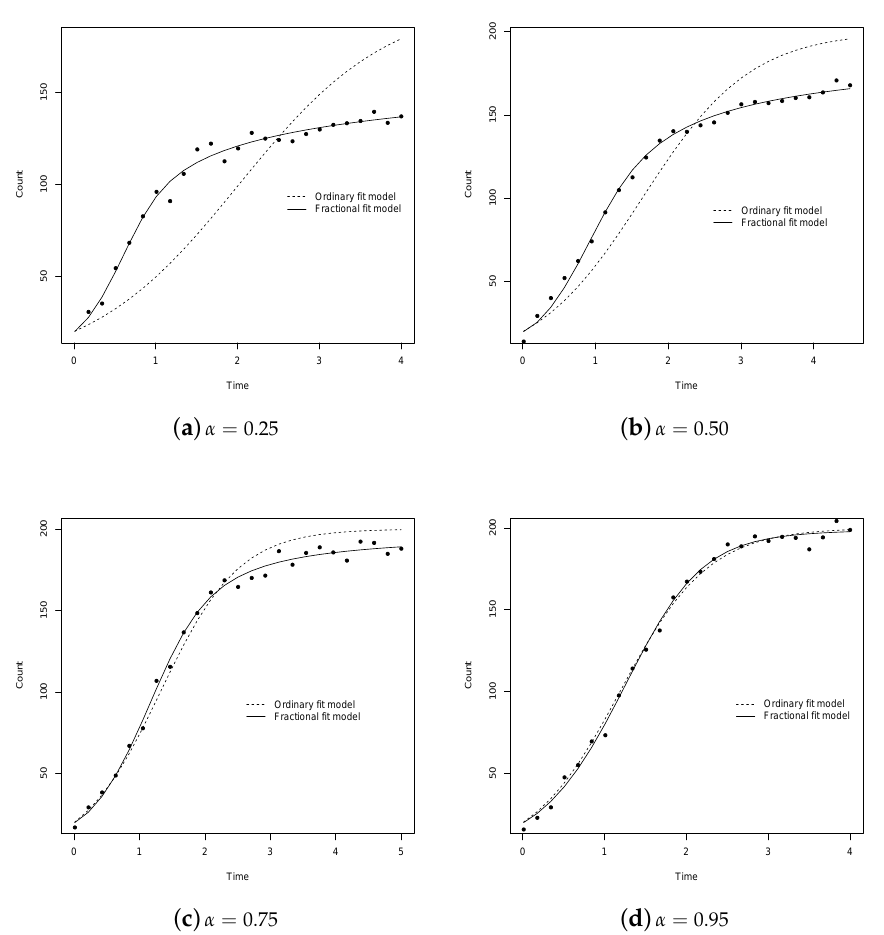
Figure 1. Synthetic data from the model Equations (6) and